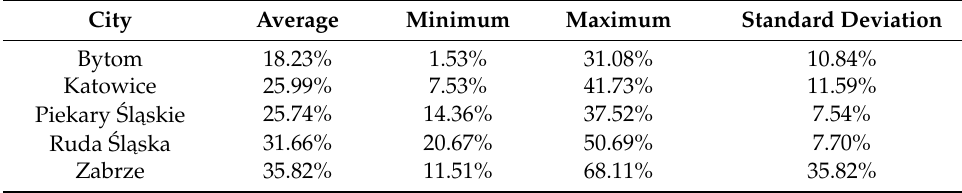
Figure 8. Ratio of liabilities to the annual budget revenues for 2003–2020 (in %) for the city of Piekary Ś l ą skie. Source: own elaboration. Table 3. Statistics for the liabilities of the examined